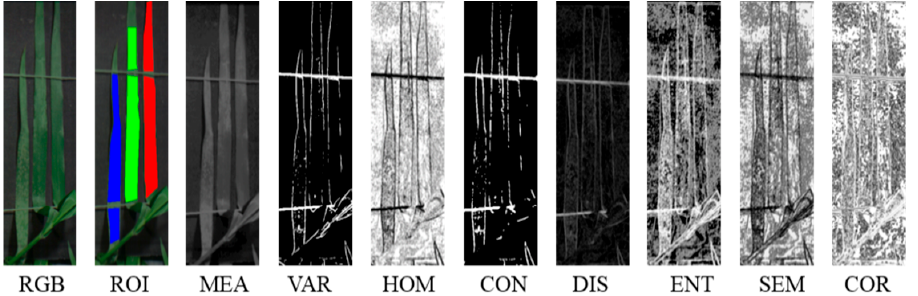
Figure 6. Texture images at wavelength of 533.5 nm. Note: MEA = mean; VAR = variance; HOM = homogeneity; CON = contrast; DIS = dissimilarity; ENT = entropy; SEM = second moment; COR = correlation).